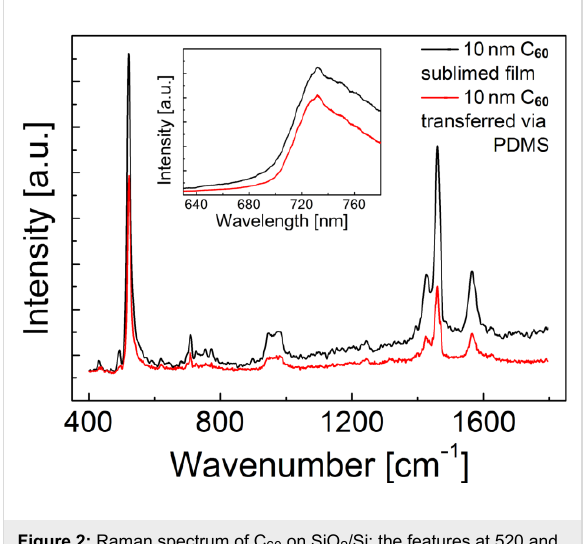
Figure 2: Raman spectrum of C 60 on SiO 2 /Si; the features at 520 and 900–1000 cm − 1 correspond to the Si substrate, the peak at 720 cm − 1 and the region between 1400 and 1600 cm − 1 with the relatively sharp line at around 1470 cm − 1 are characteristic for C 60 ; [31,32] insert: fluo- rescence emission spectrum (excitation wavelength = 532 nm) of the same samples with the characteristic broadened emission band at about 740 nm from excited singlet and triplet states of C 60 [33,34].